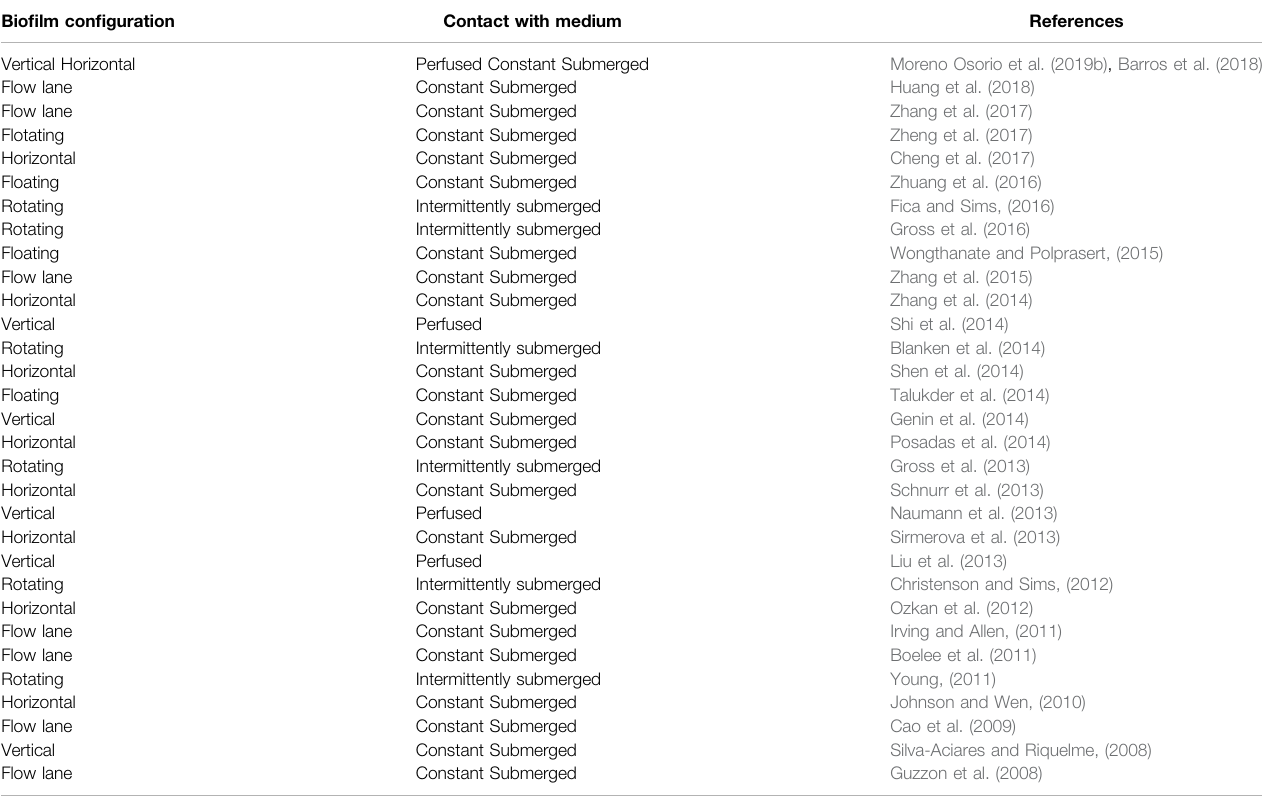
TABLE 2 | Microalgal bio fi lm reactors classi fi cation. Bio fi lm con fi guration